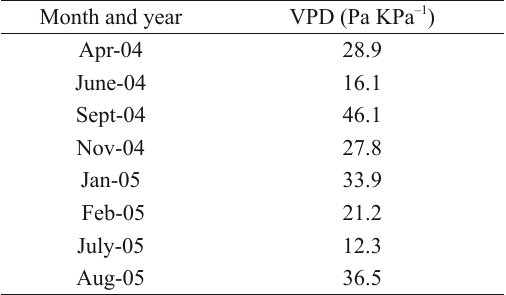
Daily maximum air vapor pressure de fi cit (VPD), measured on the days on which leaf water potential ( Ψ ) and chlorophyll a fl uorescence were L